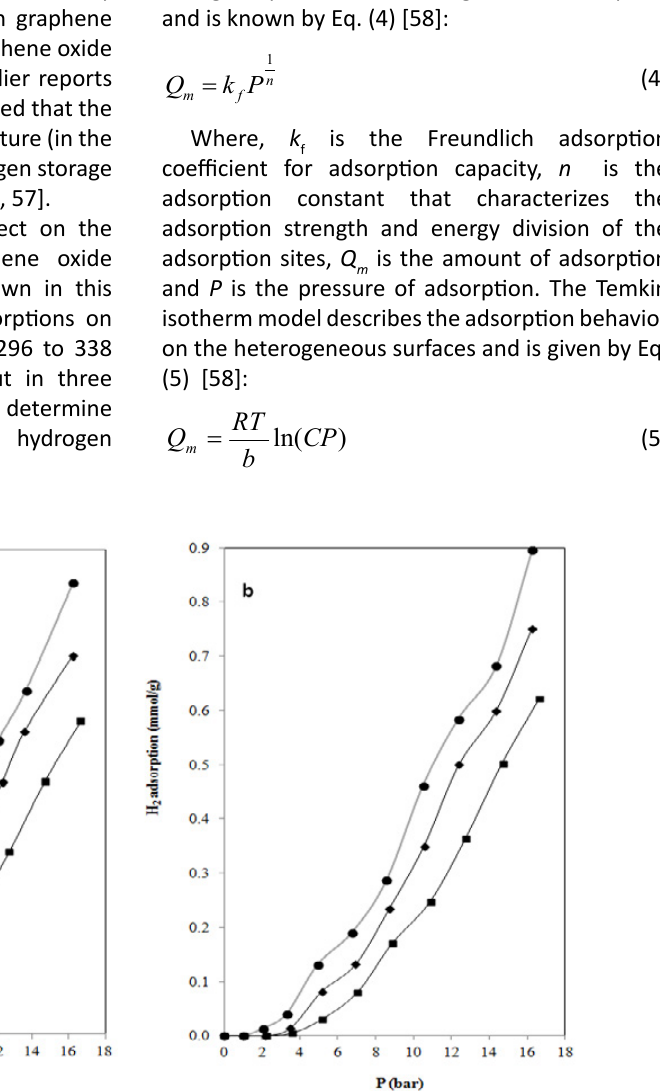
N (b) prepared samples at 298 K (●), 318 K ( ♦ ) 338 K ( ■ ) 3 4 and pressures up to 16.3 bar